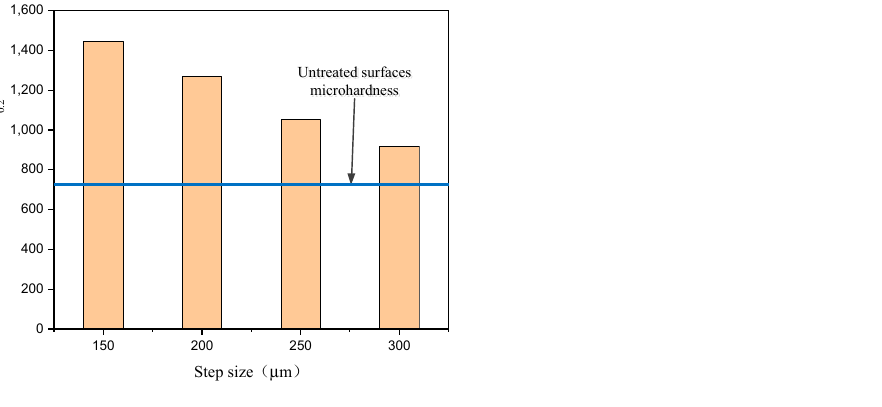
Figure 6. Microhardness of different texture spacing under the load of 1.961 N. (The blue line shows the microhardness of the untreated surface.)